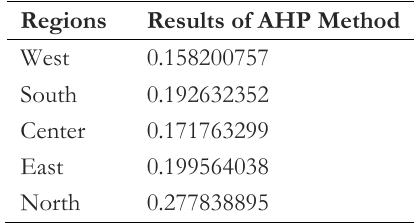
Table 7. The final results of the AHP method.